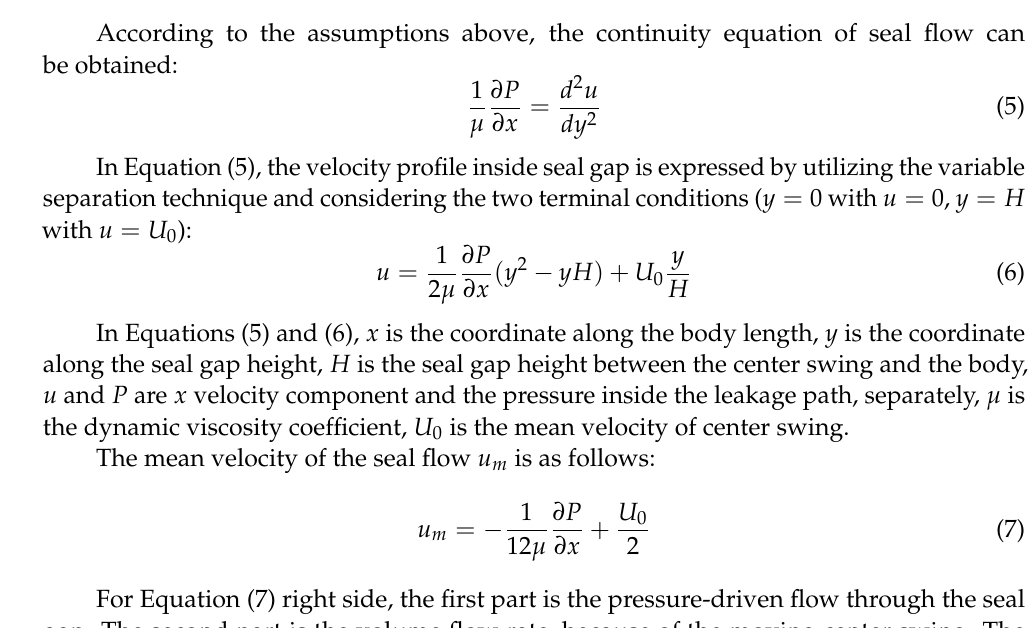
Figure 2. Leakage model of MFPSE; ( a ) physical model; ( b ) mathematical model.